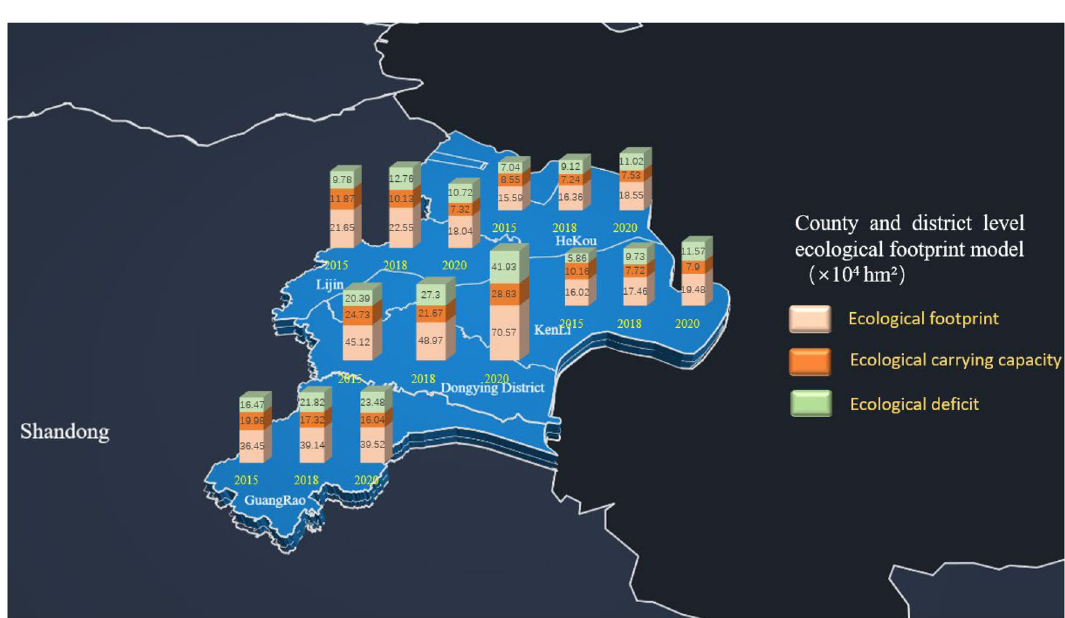
Figure 6. Total ecological footprint model for each county. This figure was created with Photoshop 2020 (https:// www. adobe. com).